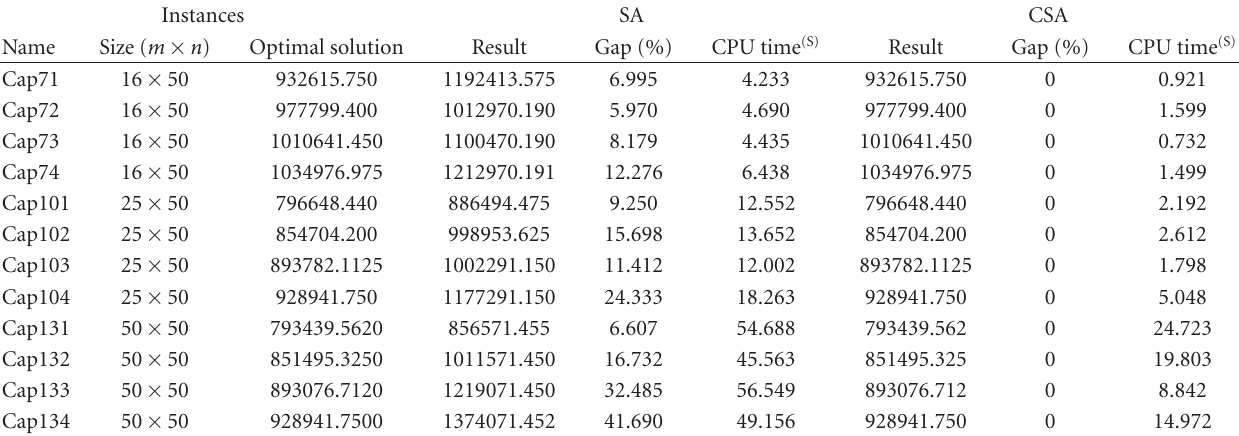
Table 1: Comparison for OR-Library instances.